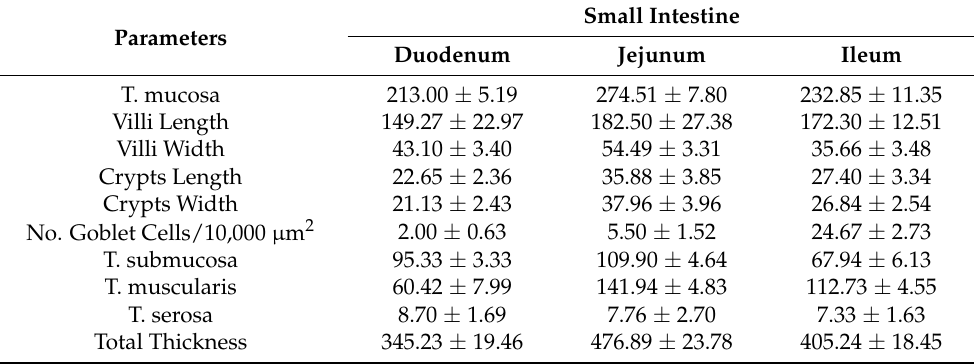
Table 3. The histometric measurements ( µ m) of the small intestine of adult male D. leporina ( n =